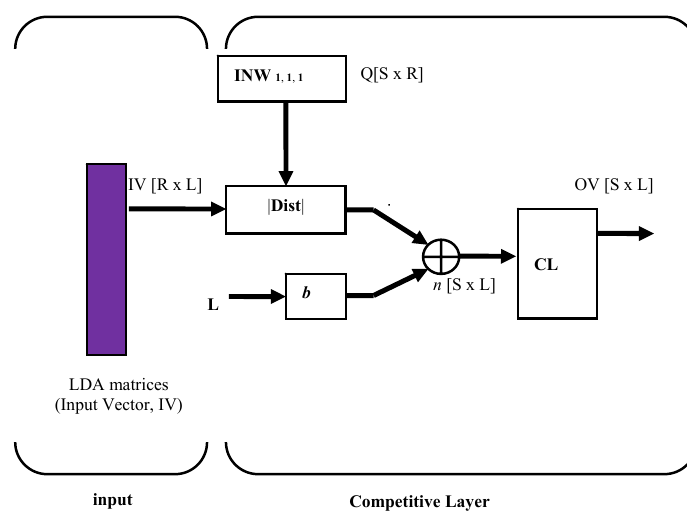
Figure 3. The architecture of LDA-CLNN